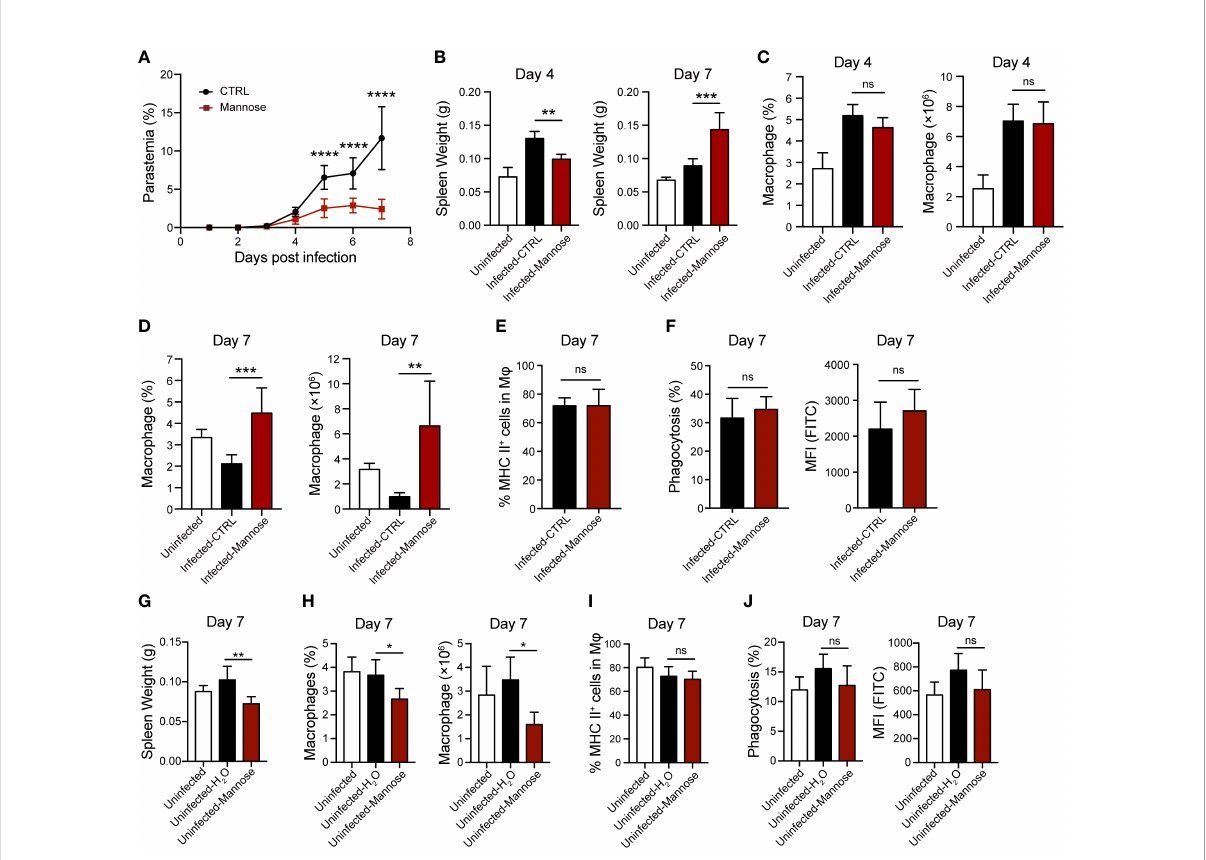
FIGURE 3 Mannose treatment increases splenic macrophage population in P. berghei -infected C57BL/6 mice. (A) Parasitemia of P. berghei- infected C57BL/6 mice (n = 8/group). Two-way ANOVA with Tukey ’ s multiple comparisons test was used to analyze differences in parasitemia between the control and mannose-treated groups. (B) Spleen weight in C57BL/6 mice (n = 10/group) 4 and 7 days post-infection (p.i.). The weights of spleens harvested from uninfected mice (n = 5/group) are shown as blank controls. (C) The frequency and number of splenic macrophages (CD45 + F4/80 + CD11b + ) in the infected C57BL/6 mice 4 days p.i. (n = 5/group) and the uninfected mice (n = 5/group) were quanti fi ed. (D) The frequency and number of splenic macrophages (CD45 + F4/80 + CD11b + ) in the infected C57BL/6 mice 7 days p.i. (n = 6/group) and the uninfected mice (n = 5/group) were quanti fi ed. (E) Quanti fi cation of the ratio of M1 macrophages (MHC II + ) to total splenic macrophages in the infected mice 7 days p.i. (F) Phagocytic capacity of splenic macrophages from the infected mice 7 days p.i. The percentage of phagocytosing FITC + macrophages and mean fl uorescence intensity (MFI) values. (G) Spleen weight in the uninfected C57BL/6 mice on day 7 (n = 5/group). (H) The frequency and number of splenic macrophages (CD45 + F4/80 + CD11b + ) in the uninfected C57BL/6 mice on day 7 (n =